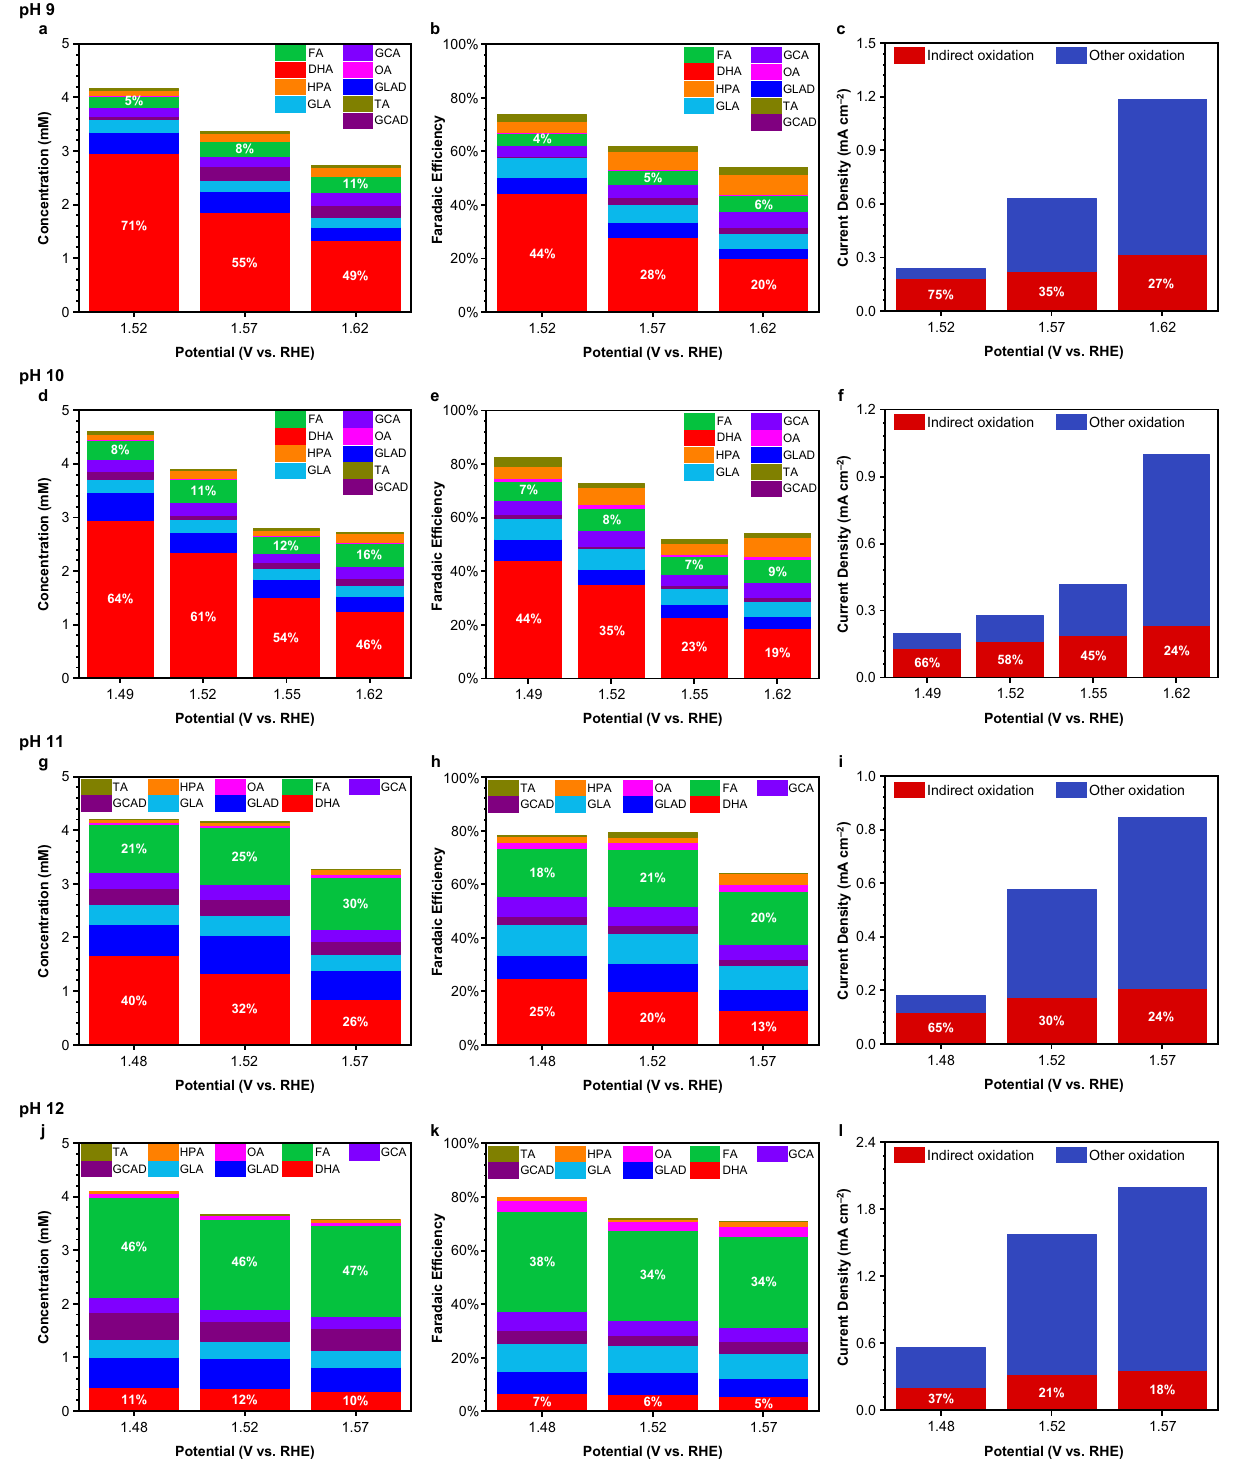
Fig.5|GlyceroloxidationresultsatpH9-12undervariouspotentialconditions. a , d , g , j Product distributions showing concentrations after passing 18C at a constantpotential.ThewhitepercentagesindicatetherelativeselectivitiesforDHA (red) and FA (green). b , e , h , k Faradaic ef fi ciencies (FEs) after passing 18C. The percentagesin white indicate theFEsfor DHA(red)and FA(green). c , f , i , l Current density from I indirect (red, percentage shown in white) and I other (blue) oxidation of